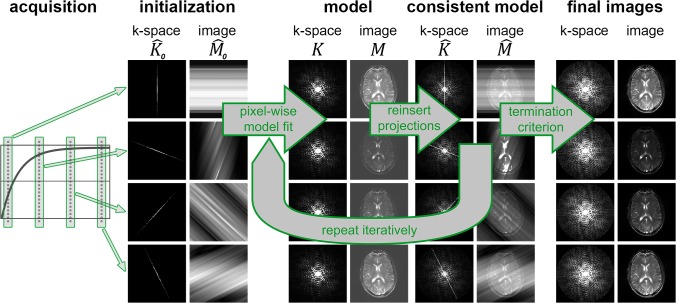
Reconstruction scheme of the algorithm.The acquisition consists of a magnetization preparation (SR for SR-MAP, IR for IR-MAP), followed by a relaxation process (solid curve) during which the projections are collected (dotted lines).